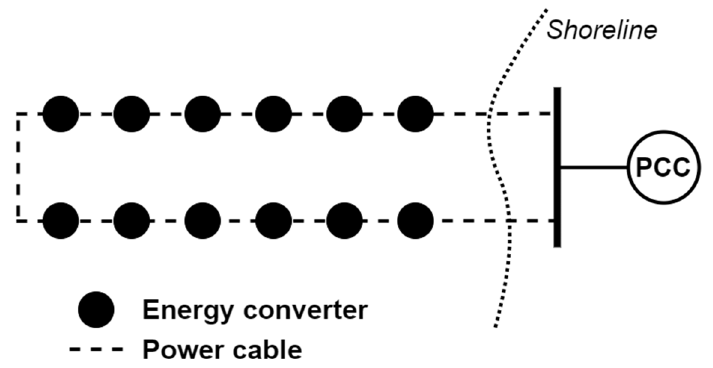
Figure 3. Double-sided ring topology.